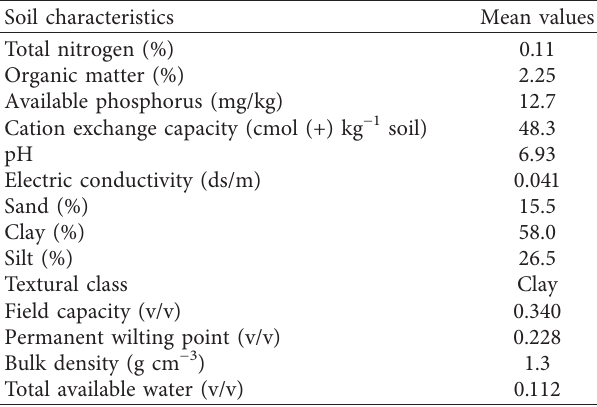
Table 1: Study site soil